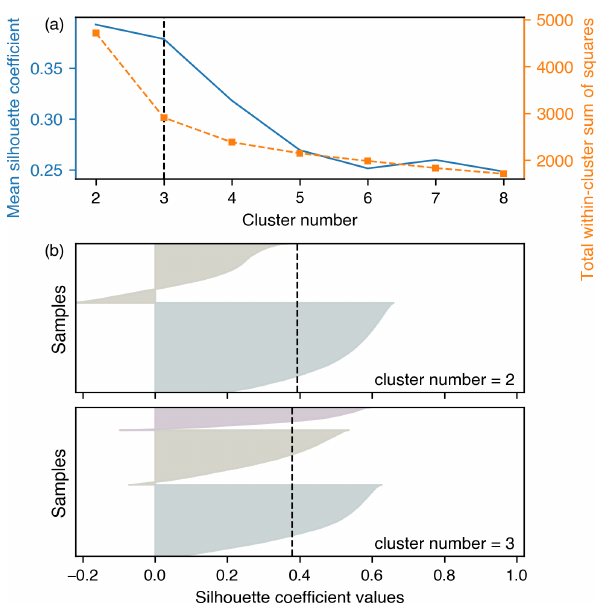
Figure A1. Determination of optimal cluster number. (a) The av- erage silhouette coefficients and total within-cluster sum of squares assessed for respective candidate cluster numbers. (b) The silhou- ette plots for various clusters when the cluster number is 2 or 3, where the x axis represents the silhouette coefficient for individual samples, and they were ordered by the coefficients and grouped by clusters in the y axis; (a) suggests that clustering the samples into either two or three groups can achieve similarly high average silhou- ette coefficients, while the silhouette plots for individual samples under the two candidate numbers in (b) further suggest that clus- tering into three groups would be the best choice because a cluster with all below-average silhouette coefficients is present when clus- tering into two groups. Therefore, we cluster annual maximum peak discharges into three main groups in the main text.